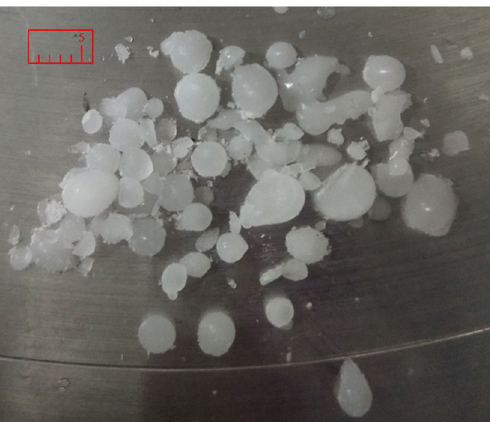
Figure 22. Ice particles.